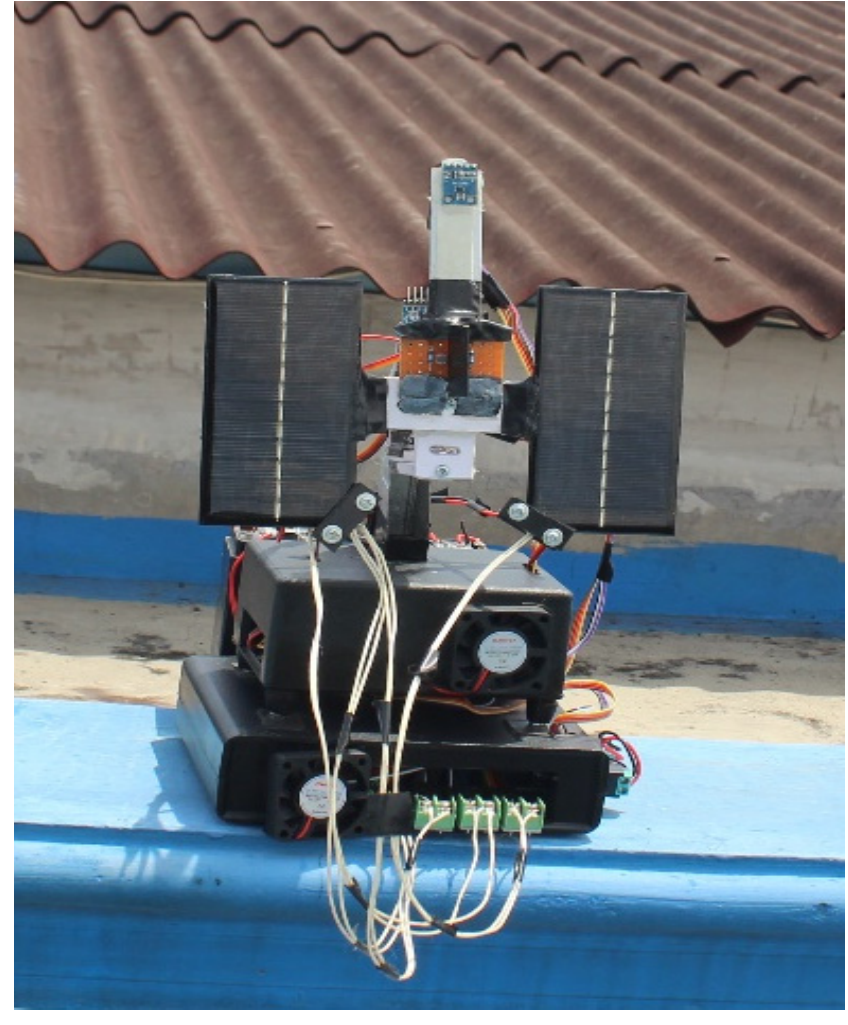
Figure 4 . Experimental setup . Figure 4. Experimental setup. Table 3. The manufacturer’s specification of the thermoelectric Table 2 . The manufacturer’s specification of the photovoltaic panel .